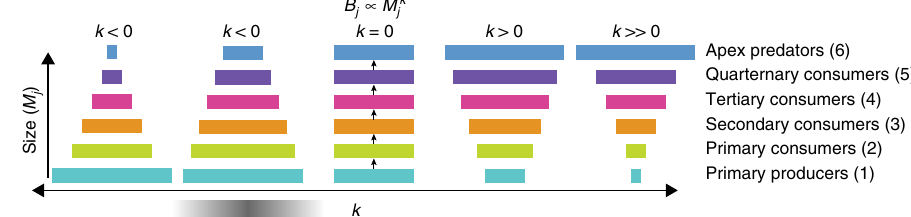
Fig. 1 Relationship between ecosystem structure and size-spectrum scaling. Width of bars represent relative abundance or biomass for value of the mass scaling exponent, k . Gray shading based on the distributions of k for marine ecosystems based on empirical estimates of trophic ef fi ciency (TE) and predator:prey mass ratios (PPMR). Arrows denote fl ow of energy and hold for all pyramids. Trophic compartment (level) is given on